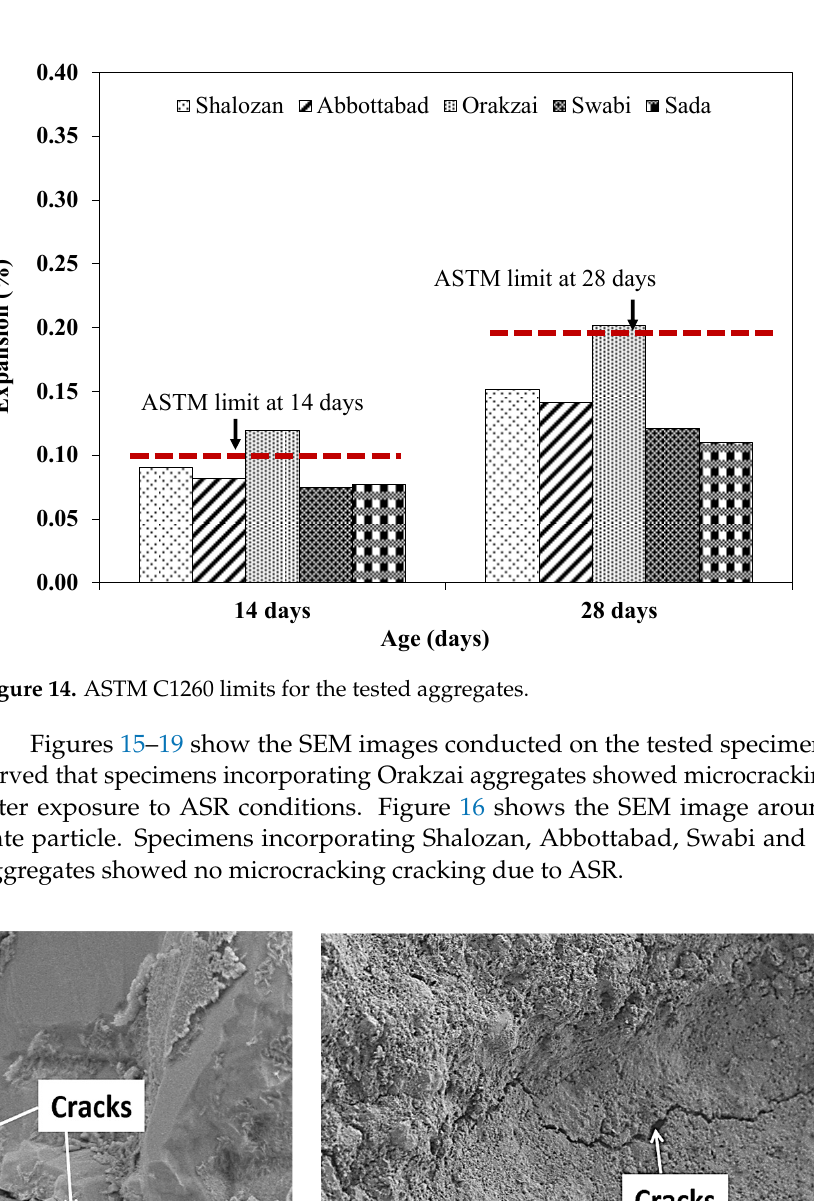
Figure 13. Expansion results of various tested aggregates.